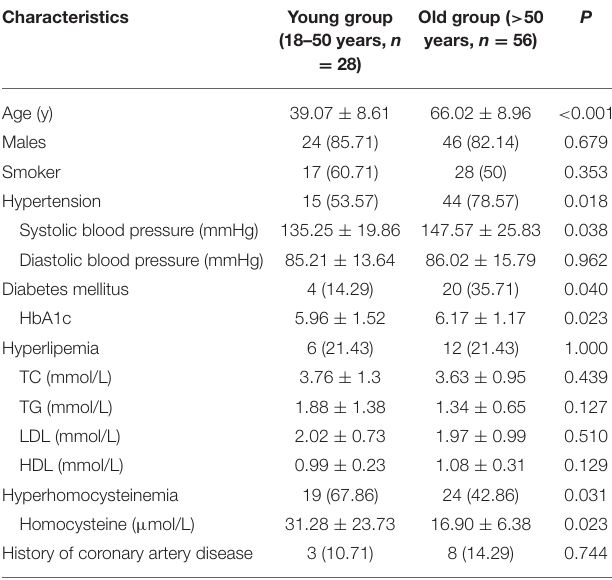
TABLE 2 | Characteristics of patients in the two groups.